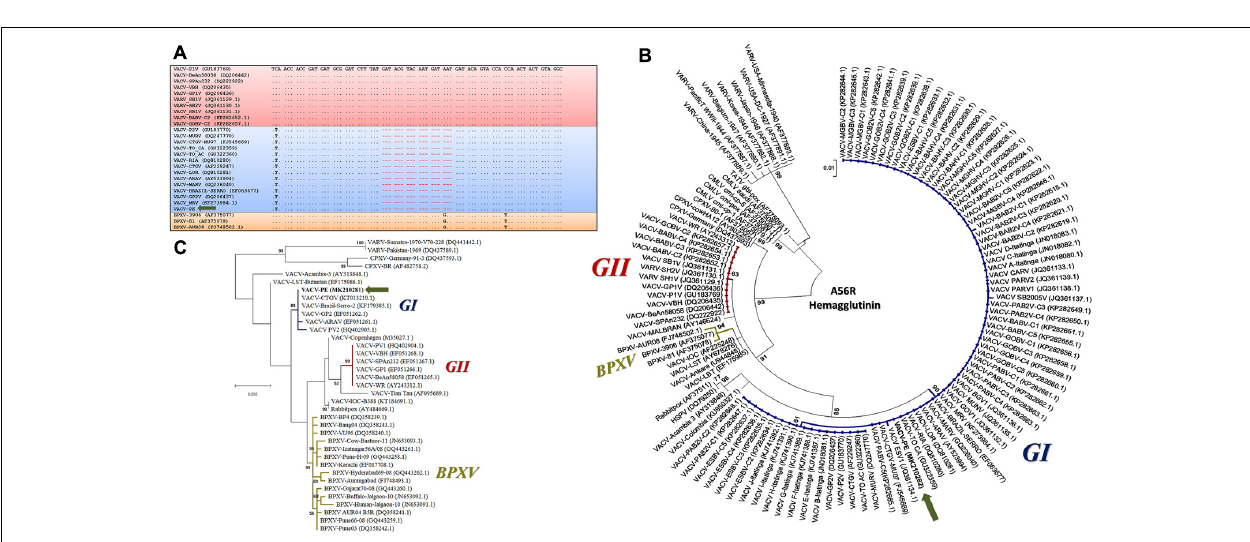
FIGURE 4 | Phylogenetic analyses based on the A56R and B5R gene sequences from vaccinia virus Pernambuco (VACV-PE) and other Orthopoxviruses (OPVs). (A) Alignment of nucleotide sequences from a fragment of the VACV-PE A56R gene with other OPV sequences. The sequences were obtained from GenBank and aligned using the ClustalW method. Nucleotide positions are shown according to the VACV-PV1 (GU183769). The (.) indicates identity and (-) indicates nucleotide deletions. The blue and red boxes highlight GI and GII VACV-BR, respectively, and the orange box highlights the Asiatic buffalopox virus sequences. The VACV-PE isolate is indicated by a green arrow. (B) A56R Phylogenetic tree constructed by the maximum likelihood method, using the Hasegawa–Kishino–Yano model of nucleotide substitutions, gamma distribution, 1000 bootstrap replicates, and the MEGA software version X. The VACV-PE highlights and accession numbers are indicated. The blue, red, and gold subtrees highlight GI and GII VACV-BR, and the Asiatic buffalopox virus sequences, respectively. The VACV-PE isolate is indicated by a green arrow. (C) B5R phylogenetic tree constructed by the maximum likelihood method, using the Hasegawa–Kishino–Yano model of nucleotide substitutions, 1000 bootstrap replicates, and the MEGA software version X. The VACV-PE highlights and accession numbers are indicated. The blue, red, and gold subtrees highlight the GI and GII VACV-BR, and the Asiatic buffalopox virus sequences, respectively. The VACV-PE isolate is identified by a green arrow. The accession numbers are presented between parentheses in respective